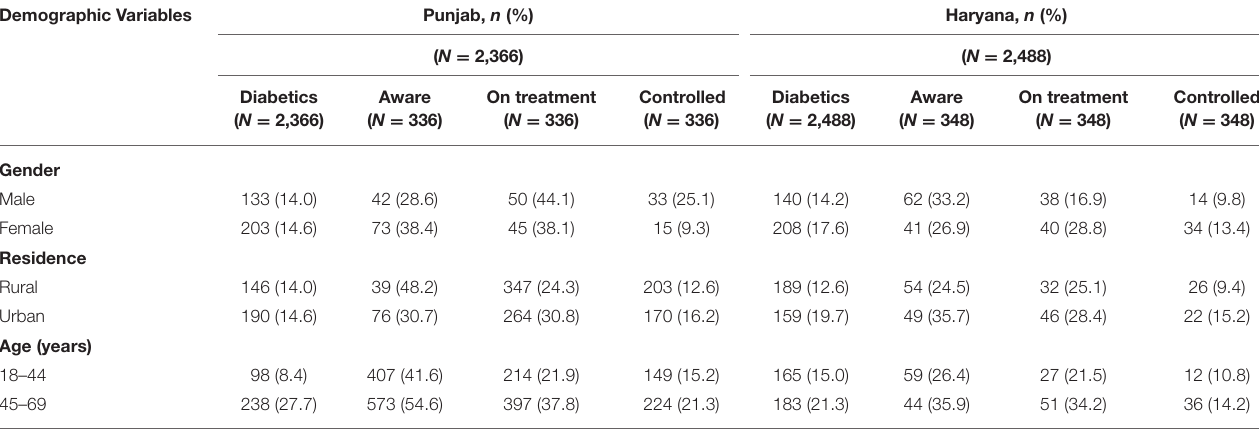
TABLE 3 | Proportion (%) of diabetes awareness, treatment, and control in Punjab and Haryana, India. Demographic Variables